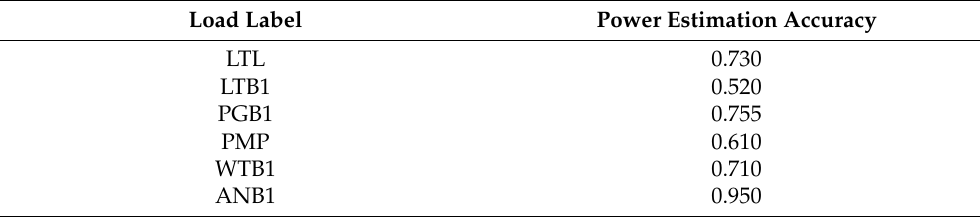
Table 6. Power demand estimation accuracy associated with the MTC data. Load Label